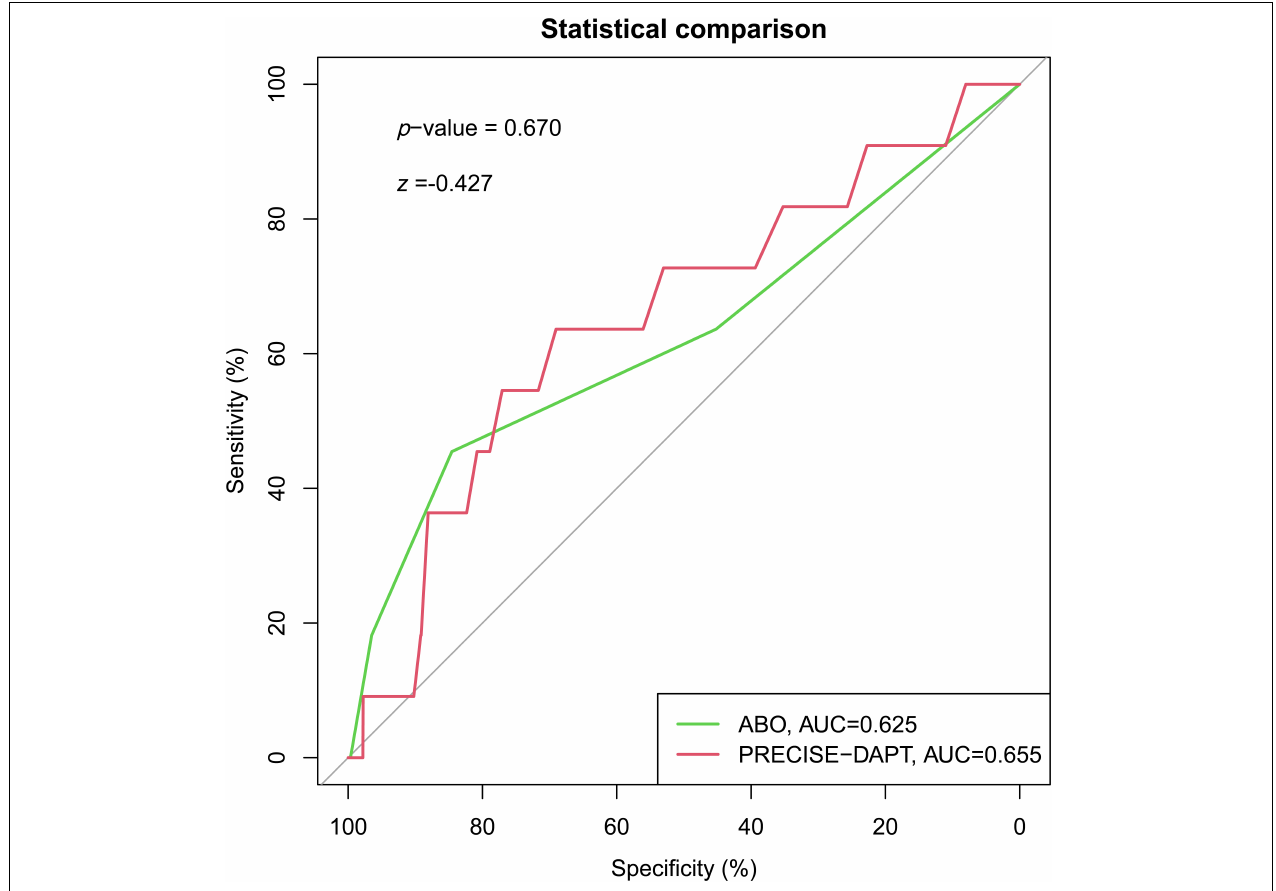
FIGURE 4 | Receiver operating characteristic curve for the prediction of BARC = 3 or 5 type bleeding events by PRECISE-DAPT and ABO risk score systems in overall patients with 1-year DAPT after PCI [AUC: 0.655 and 0.625, respectively; (95% CI, 0.486–0.823) and (95% CI, 0.428–0.823), respectively; p = 0.076 and p = 0.152, respectively). The C-statistics for the two risk models were compared to each other by the DeLong test ( z = –0.427, p =